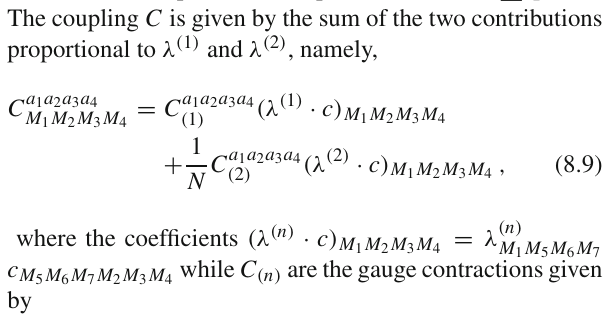
(cid:9) (cid:11) q = i